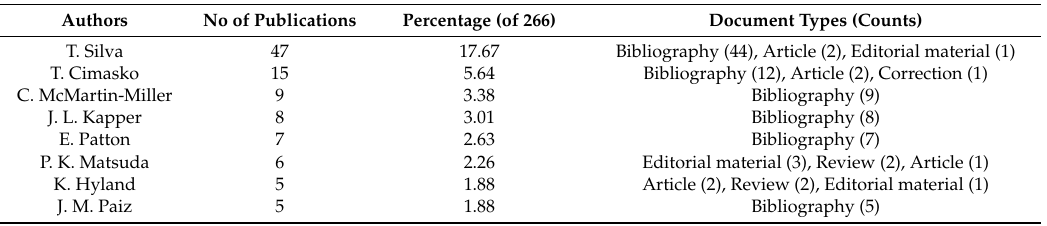
Table 4. The most published authors in SSCI and A & HCI.